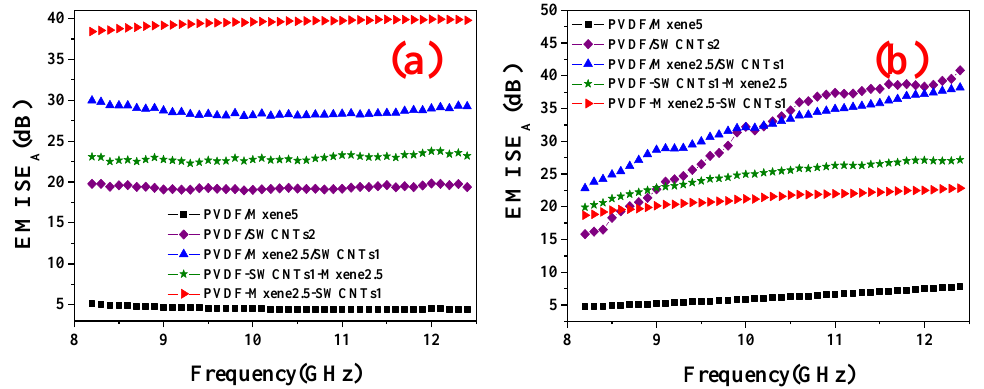
Figure 6. ( a ) Experimental and ( b ) theoretical EM shielding absorption (SE A ) of PVDF/MXene5, PVDF/SWCNTs2, PVDF/MXene2.5/SWCNTs1, PVDF-SWCNTs1-MXene2.5, and PVDF-MXene2.5- SWCNTs1.